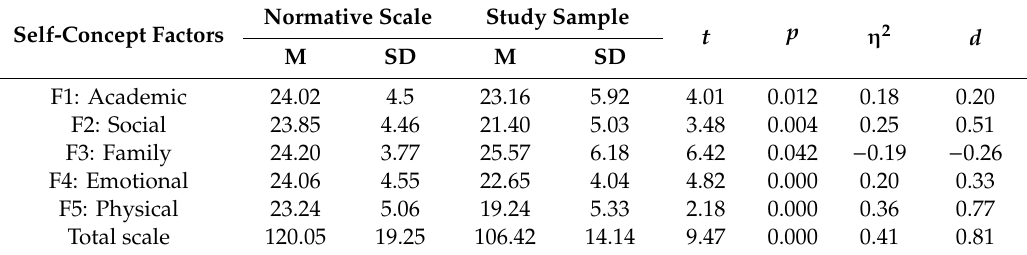
Table 1. Mean self-concept scores for the study sample and the normative